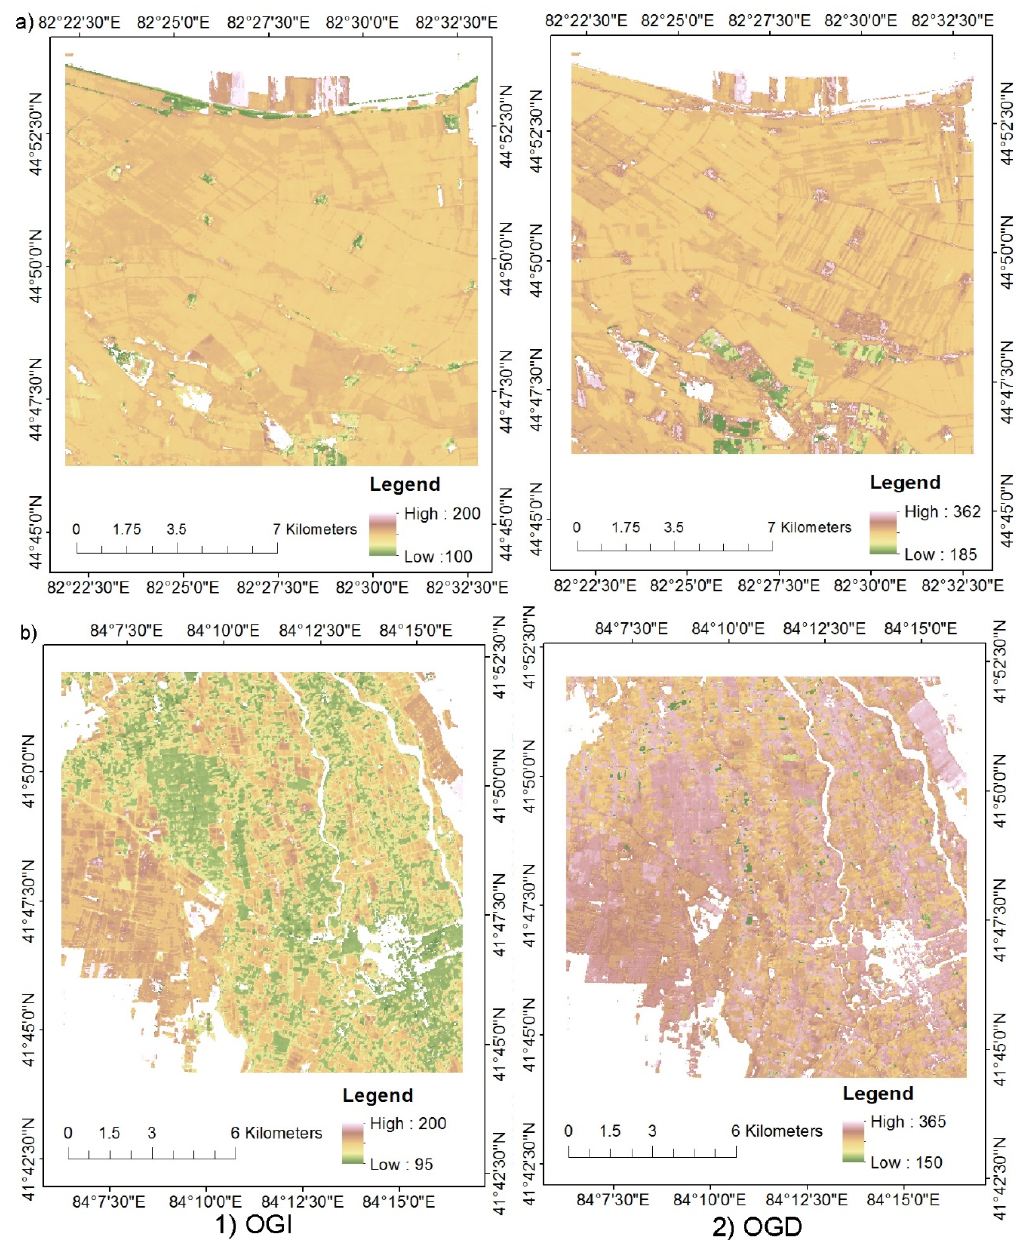
Figure 7. Calculated onset date of greenness increase (OGI) and greenness decrease (OGD) in ( a ) Bole and ( b ) Luntai. Table 7. The onset date of greenness increase (OGI) and greenness decrease (OGD) of each land use types in Luntai and Bole.